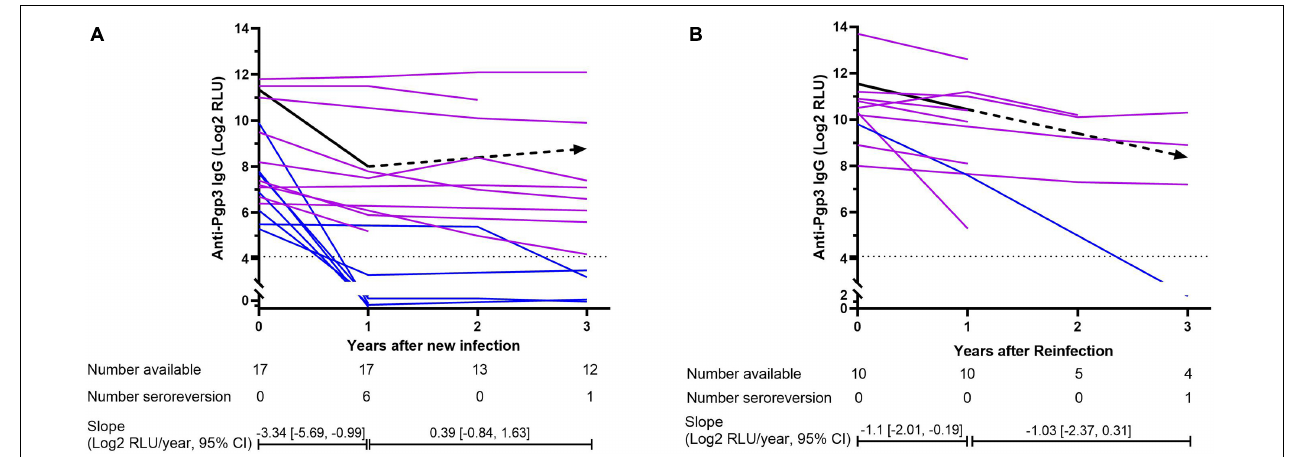
FIGURE 4 | Dynamics of anti-Pgp3 antibody in C. trachomatis new infection (A) and reinfection (B) . Dynamics of anti-Pgp3 antibody was analyzed in 17 newly CT-infected subjects and 10 CT reinfected subjects. Purple lines indicate the subjects who were seropositive for anti-Pgp3 during the follow-up, whereas blue lines indicate those with seroreversion. Black line represents the dynamics of antibody change estimated by GEE model analysis in which the solid lines mean the trend of antibody change is statistically significant while dash lines mean no statistically significant. In addition, dot lines indicate the cutoff value of anti-Pgp3 IgG antibody (Log2 RLU = 4.1). Slopes were estimated by GEE